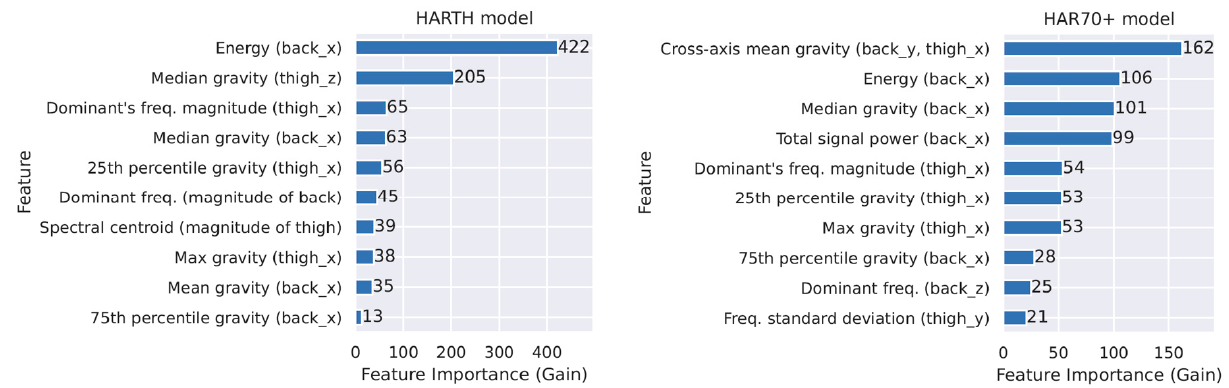
Figure 2. The 10 features that provide the most information for activity type prediction in the HARTH model ( left ) and the HAR70+ model ( right ).